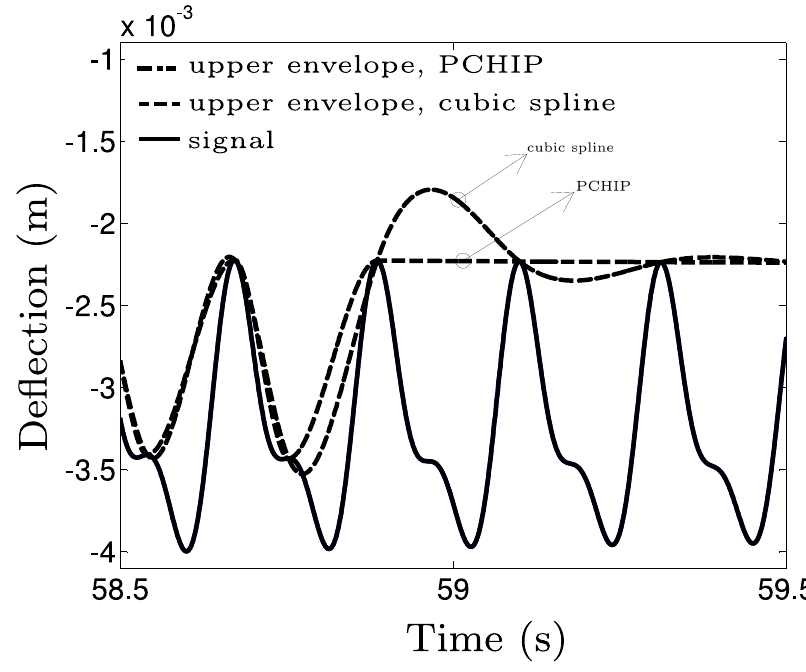
Figure 7. Comparison of the upper envelopes in the sifting process based on cubic spline and PCHIP for vertical transient response of a cracked Jeffcott rotor at shaft speeds close to half of its first critical